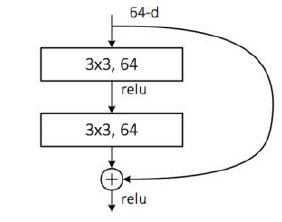
Figure 5. An Original Residual Module